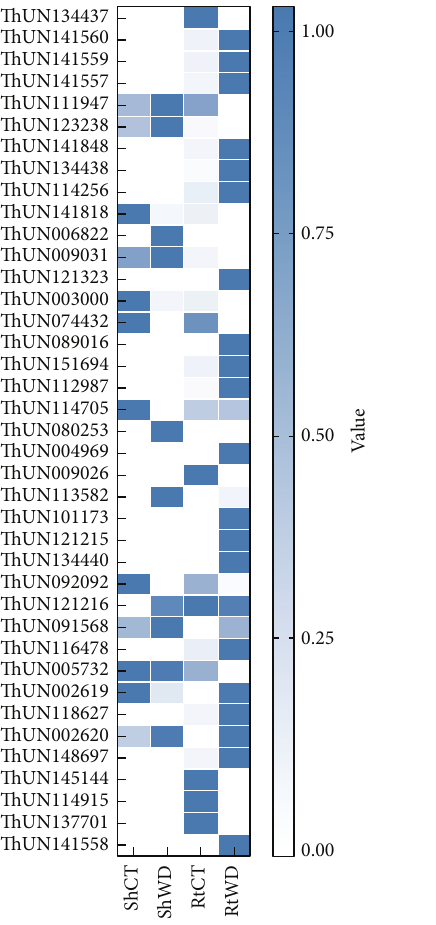
Figure 7: Heatmap showing the expression profiles of transcripts involved in the response to abiotic stress and ROS